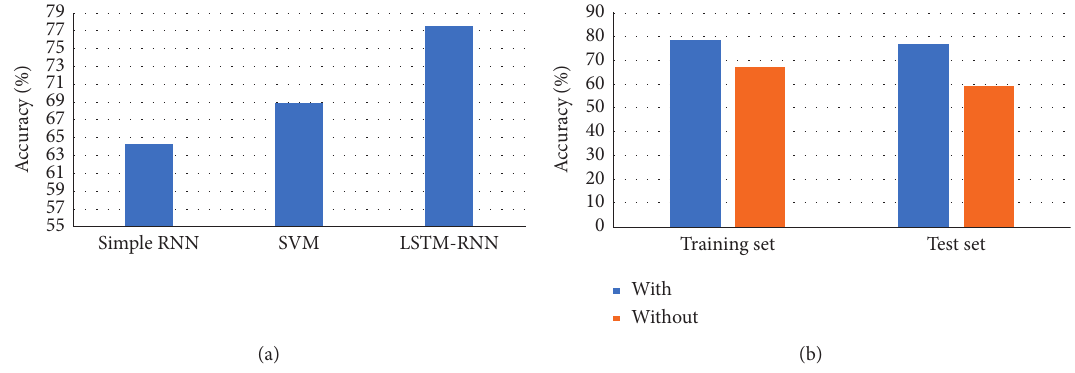
Figure 20: Model accuracy comparison. (a) LSTM-RNN unit performance (b) Impact of the multisource